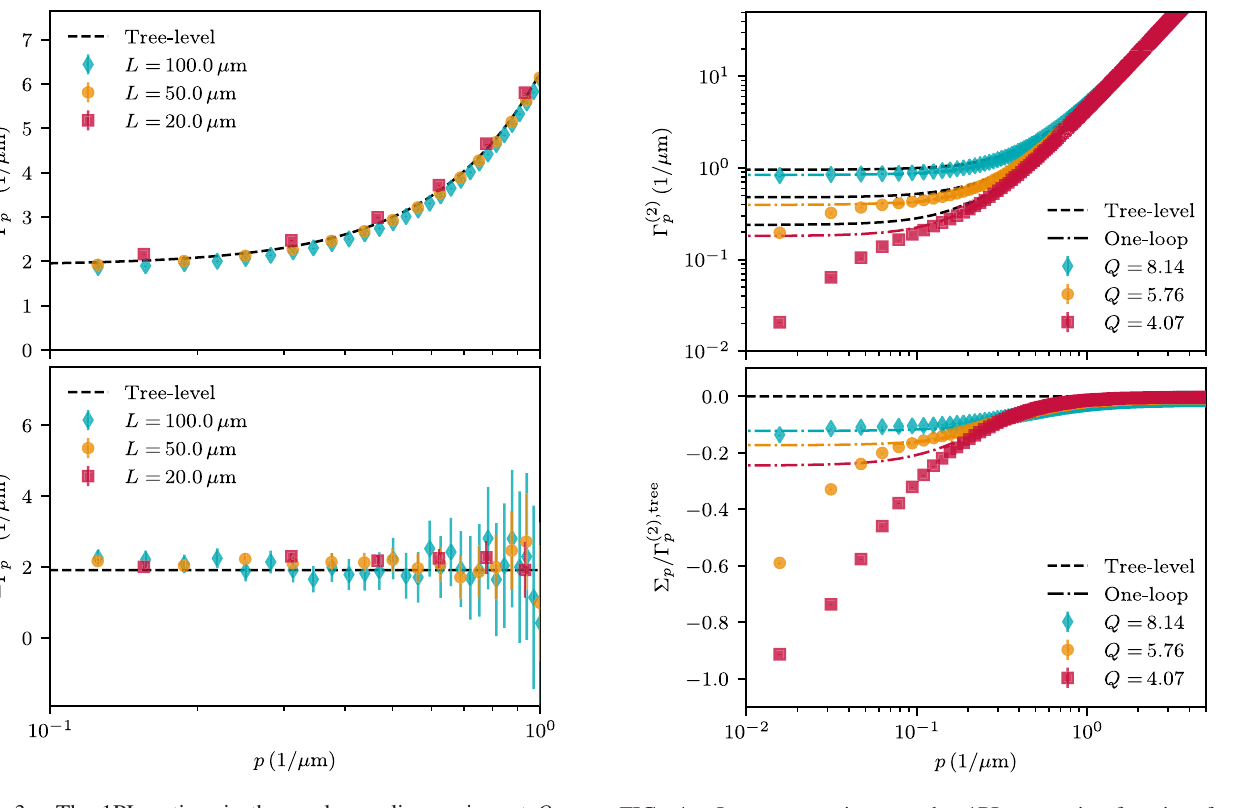
FIG. 4. Loop corrections to the 1PI two-point function for different Q in the strong coupling regime, Q ¼ 8 . 14 (blue diamonds), 5.76 (orange circles), and 4.07 (red squares). The calculated two-point function (upper) always approaches the corresponding tree-level predictions (black dashed lines) at high momenta, as expected. In the infrared, we observe deviations due to loop corrections. The corresponding colored dashed-dotted lines include the one-loop correction. The corresponding self- energy (lower) quantifies the deviations from the tree-level prediction. The corrections become more pronounced for smaller Q , as expected. Numerical results are calculated for L ¼ 200 μ m and a sample size of 10 8